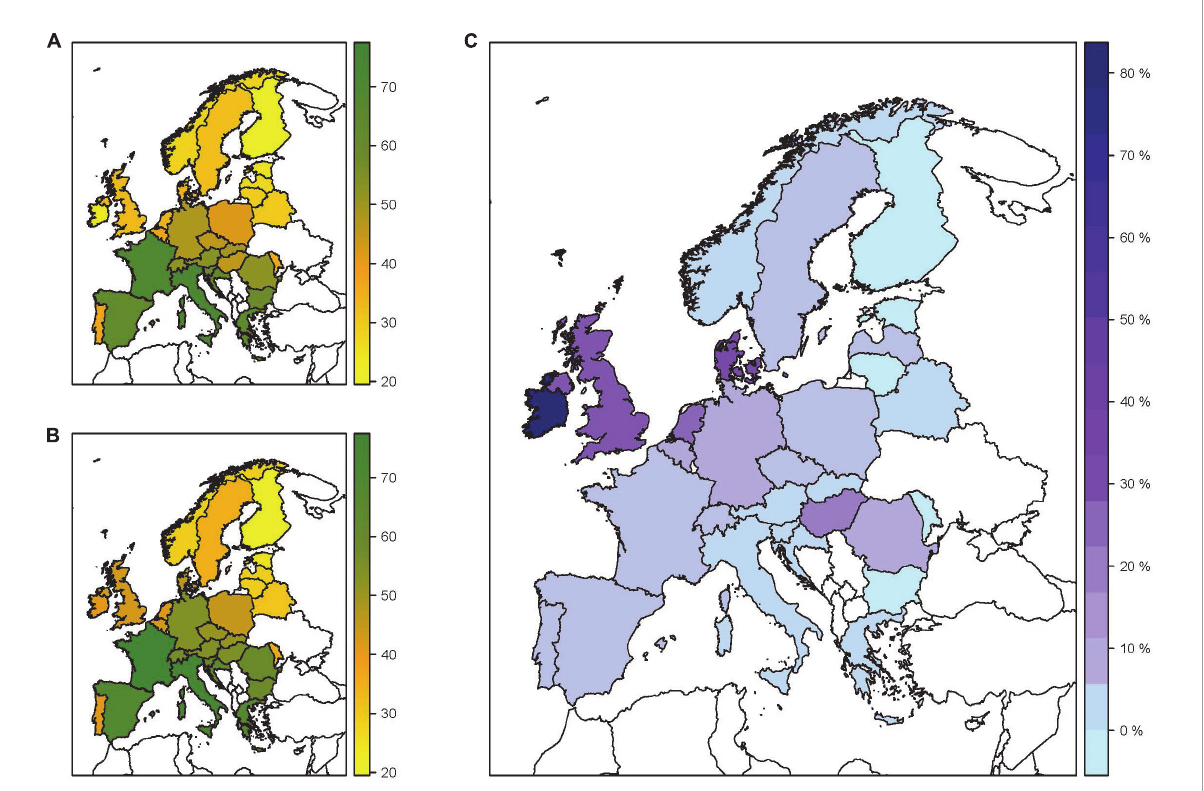
FIGURE2 Species diversity distribution maps. (A) Map showing the number of native tree species across Europe. (B) Map showing the total number of native and NNTs across Europe. (C) Contribution of non-native species to the total number of tree species diversity in Europe (Percentage gain in species diversity). Tree species distribution data are taken from EUFORGEN and EU Forest